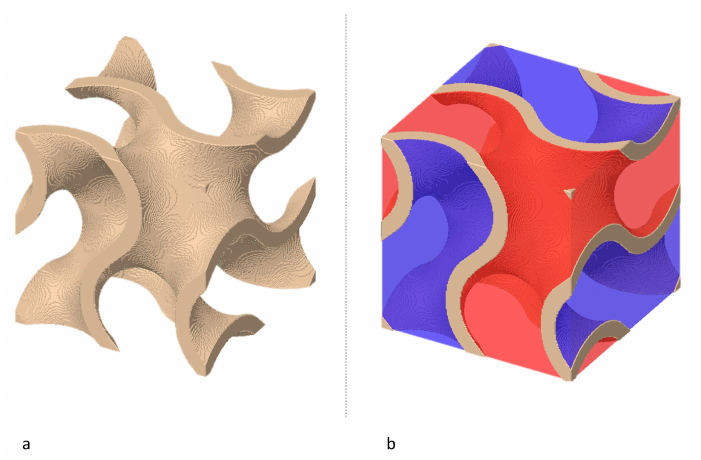
Figure 1. ( a ) Sheet-based gyroid structure; ( b ) gyroid structure with labelled two-tunnel